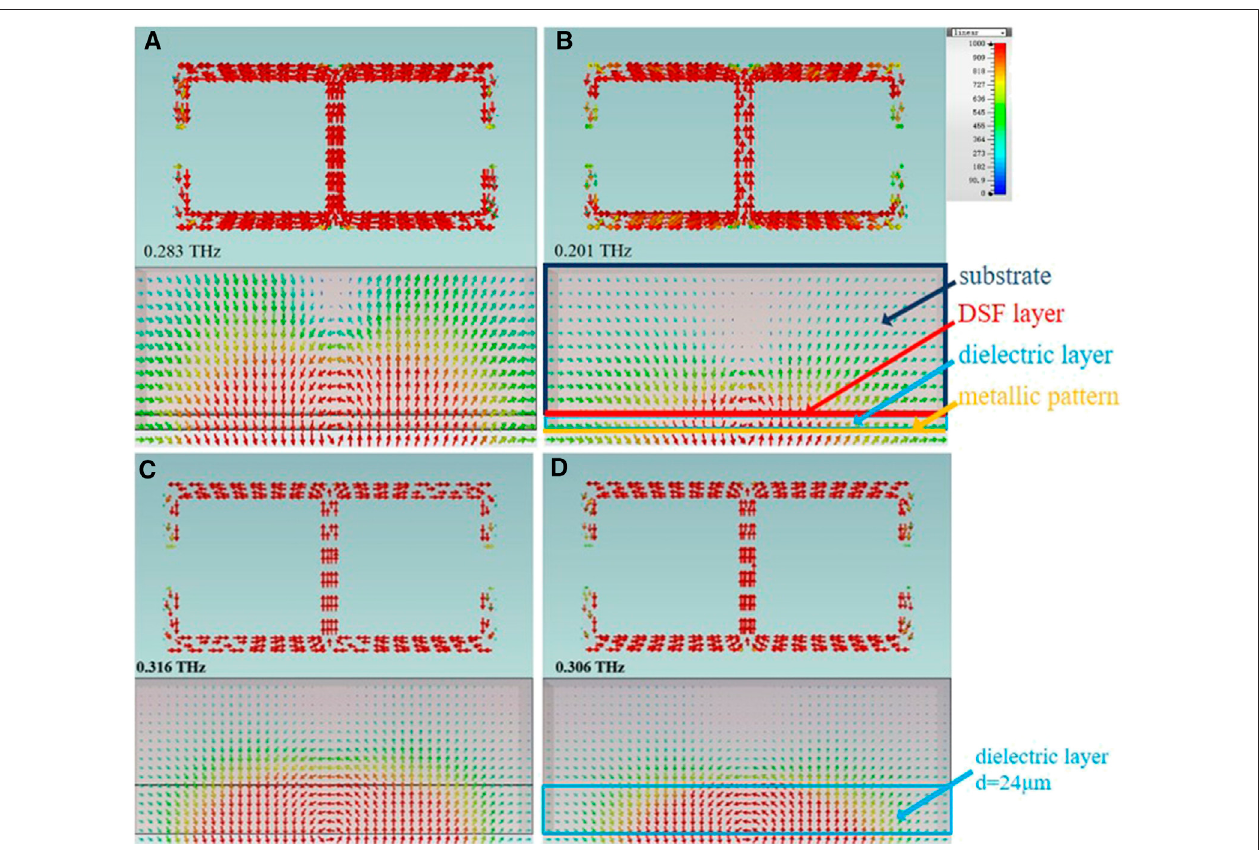
FIGURE 6 | Current distribution and magnetic fi eld distribution with d 2 (cid:2) (A, B) 5 μ m and (C, D) 24 μ m, corresponding to E F (cid:2) (A, C) 30 meV and (B, D) 150 meV. DSF, Dirac semimetal fi lm; PEC, perfect electric conductor.